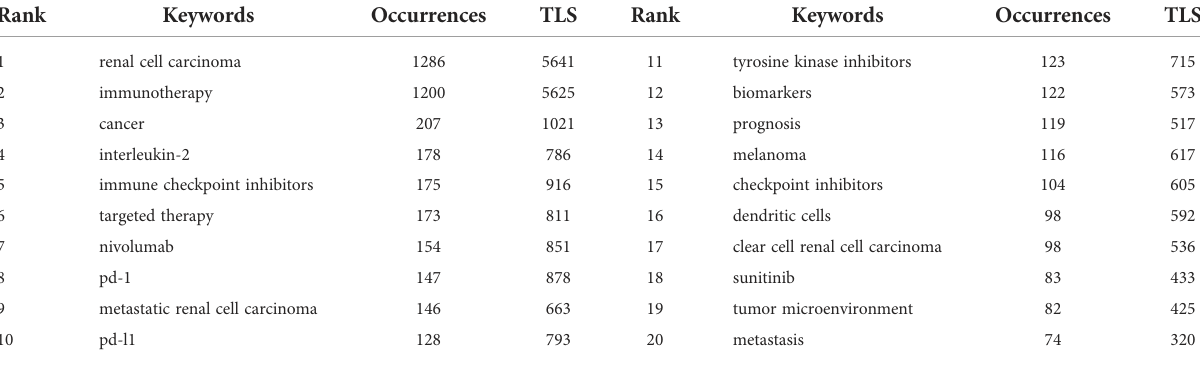
TABLE 7 Top 20 co-occurrence keywords involved in the research of RCC